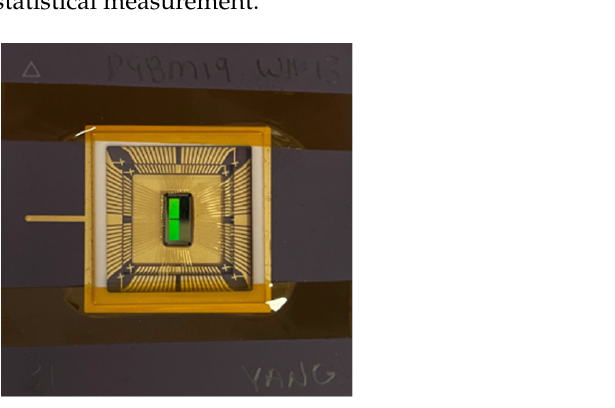
Figure 9. QIS chip.